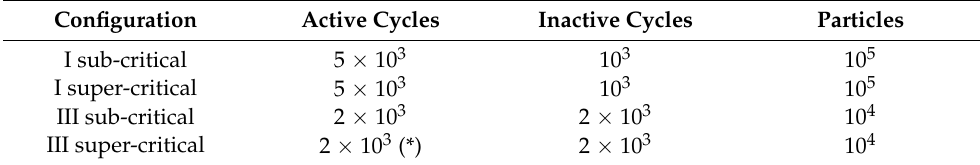
Table 2. Numerical simulation parameters for benchmark configurations: forward simulations.